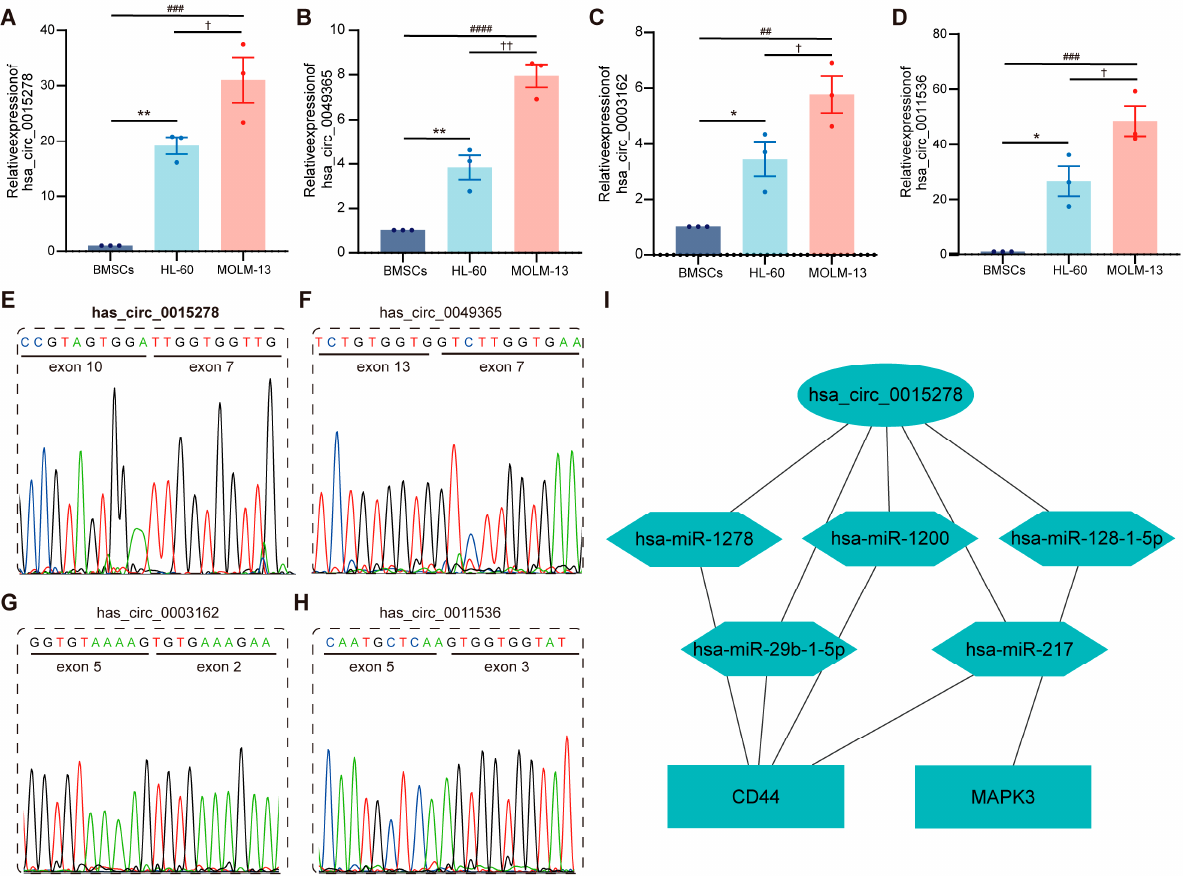
Figure 5. Validation of relative expression levels and structures of candidate circRNAs. ( A – D ) Validation of relative expression levels of circRNAs using qRT-PCR ( A , hsa_circ_0015278; B , hsa_circ_0049365; C , hsa_circ_0003162; and D , hsa_circ_0011536). The p value was calculated using a Wilcoxon